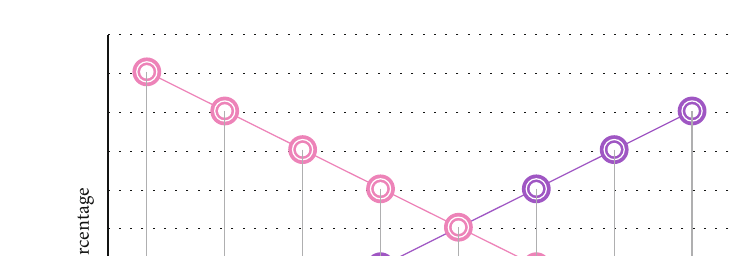
Figure 5: How to Get Travel Information.